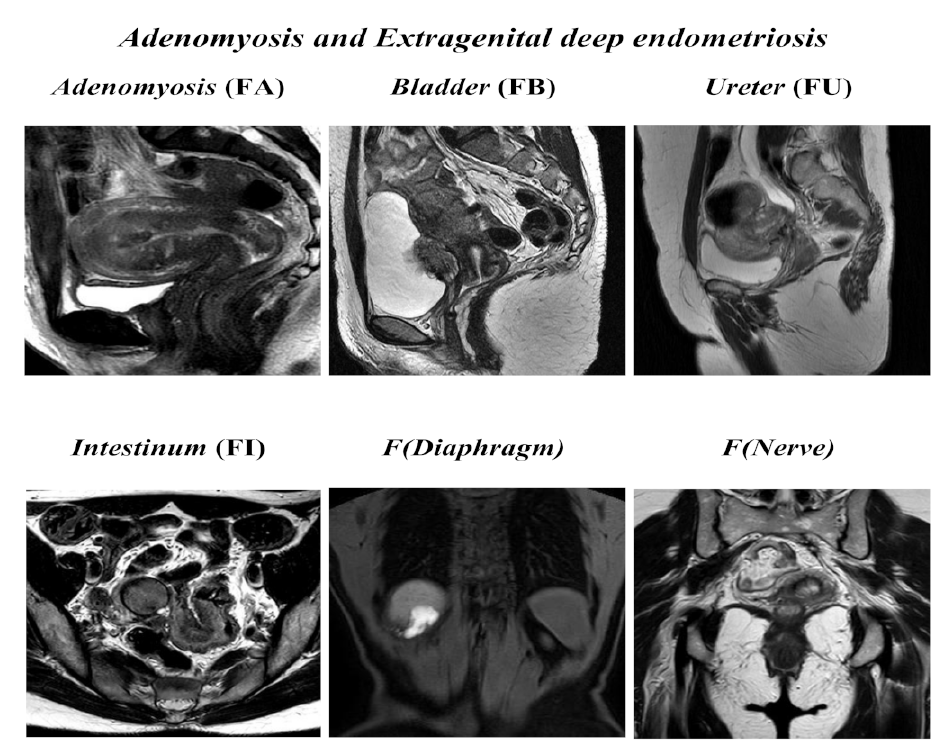
Figure 2. ENZIAN score 2020: MRI overview of extragenital deep endometriosis and adenomyosis. Deep infiltrating endometriosis (DIE): considers all implants showing sub-peritoneal infiltration of >5 mm. The ENZIAN score defines the lesions’ base on the site and the different organs involved; they are classified in Compartment A represented by vagina or recto–vaginal space or retrocervical area (measured on cranio–caudal axis = sagittal plane), Compartment B represented by uterosacral and cardinal ligaments or pelvic sidewall (measured on mediolateral axis = axial plane), and Compartment C represented by rectal or colic wall up to 16 cm from the anal verge (measured on cranio–caudal axis = sagittal plane) . Lesions are also defined by size as follows: A/B/C 1 < 1 cm (sum of all maximal diameter); A/B/C 2 = 1–3 cm (sum of all maximal diameter); A/B/C 3 > 3 cm (sum of all maximal diameter). Each compartment is descripted